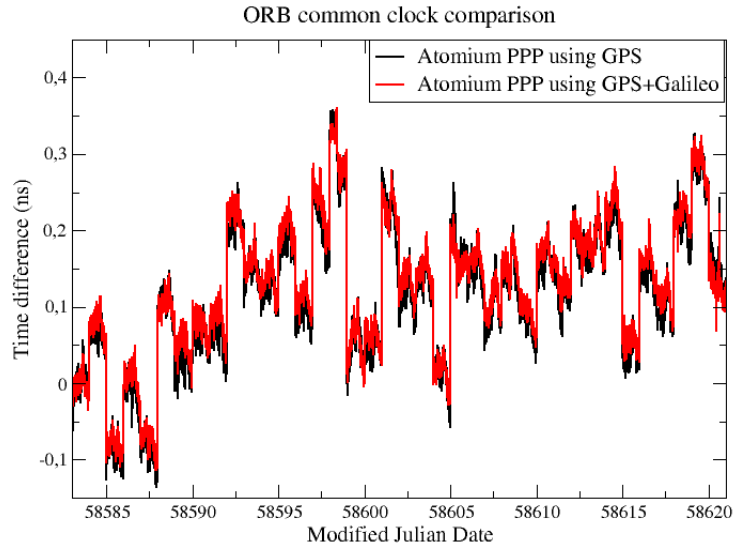
Figure 1. Common clock difference (CCD) Galileo results between BRUX and RTBS.